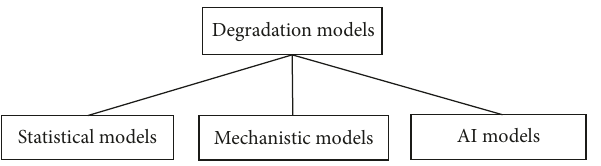
Figure 1: Main categories of degradation models. Figure 2: Main categories of statistical